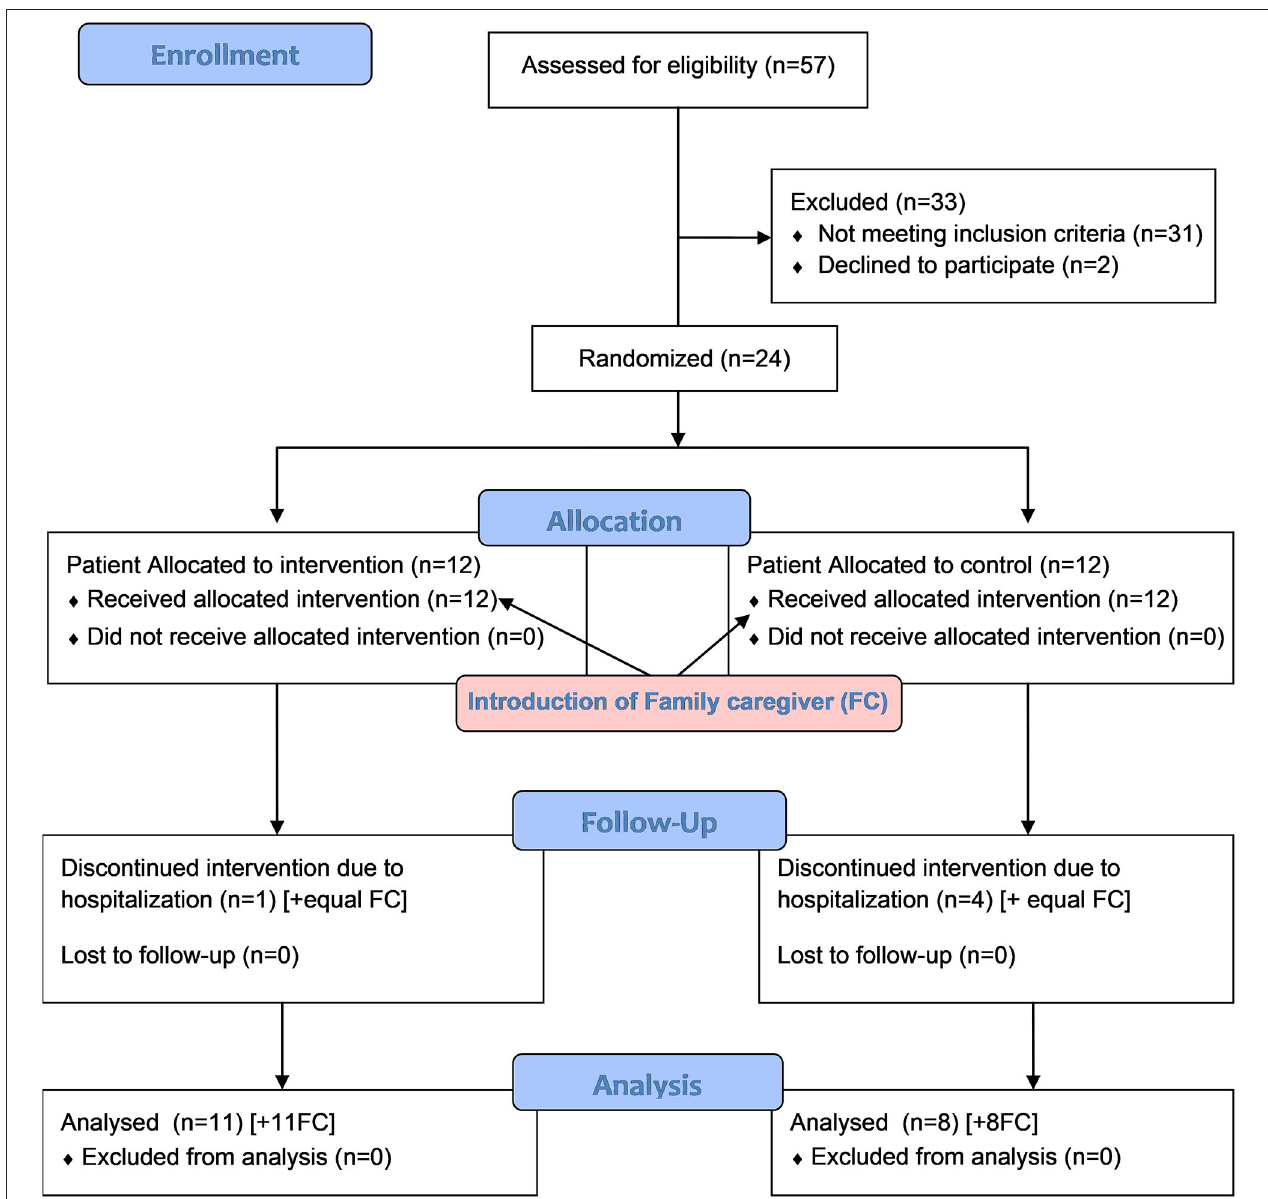
FIGURE 2 | CONSORT 2010 flow diagram of the